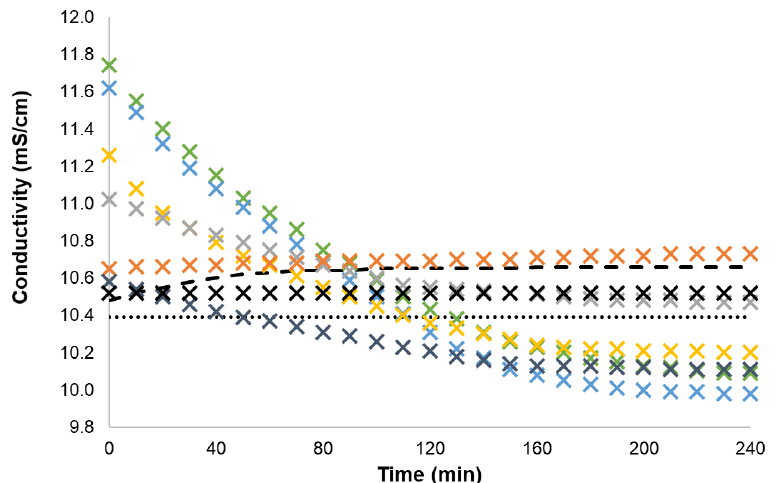
Figure 6. Conductivity data of 0.04 mol% GDIL IMCn series and of 0.08 mol% KCl in [C 2 mim][NTf 2 ] solutions upon UV irradiation time at 25 °C (round dot—pure [C 2 mim][NTf 2 ], dash—BTF6, X black cross—KCl, X green cross—IMC1, X blue cross—IMC2, X gold cross—IMC4, X gray cross—IMC6, X orange cross—IMC8, X blue-gray cross—IMBENZ).